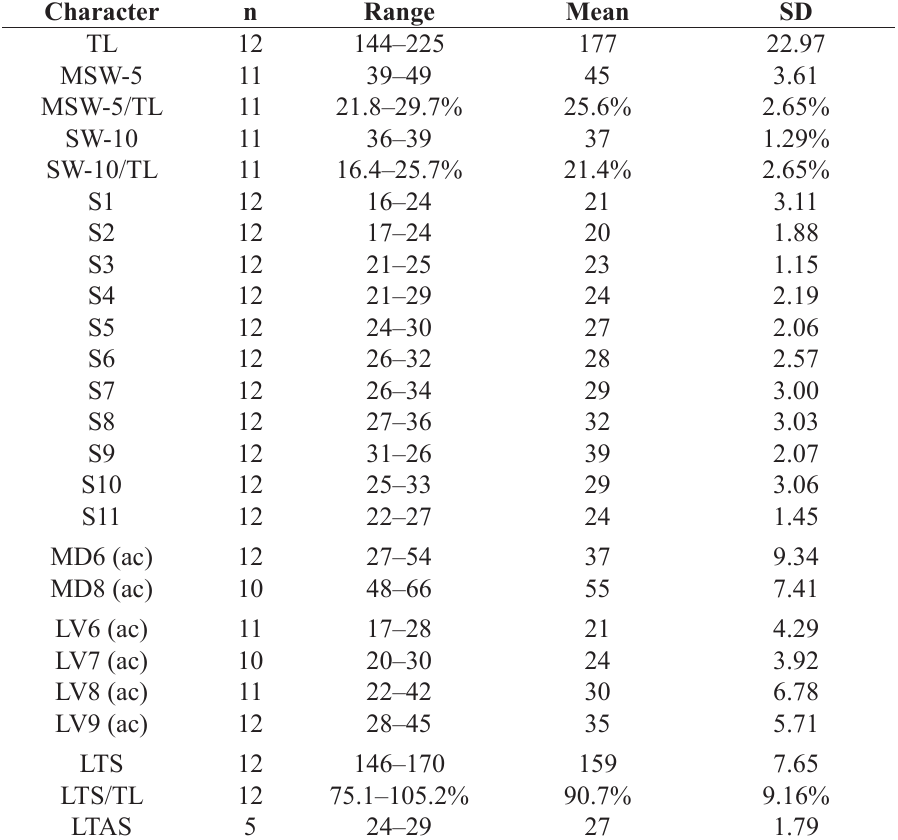
Table 8. Measurements from light microscopy of Echinoderes hviidarum sp. nov. (in µm), including number of measured specimens (n) and standard deviation (SD). Abbreviations: (ac) = acicular spine; LTAS = lateral terminal accessory spine; LTS = lateral terminal spine; LV = lateroventral; MD = middorsal; MSW-5 = maximum sternal width, measured on segment 5 in this species; S = segment lengths; SW-10 = standard width, always measured on segment 10; TL = trunk